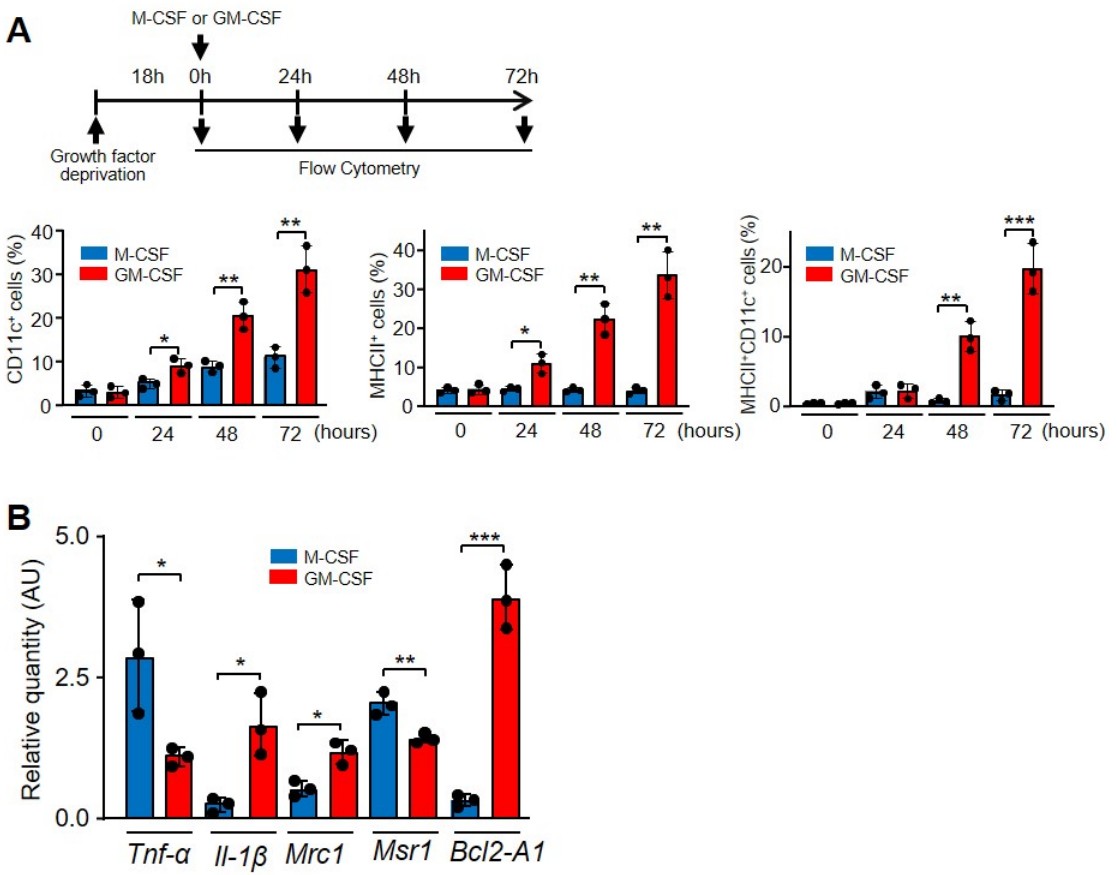
Figure 6. GM-CSF induced a different phenotype of macrophages in relation to M-CSF. ( A ) Characterization of CD11c and MHC II expression. The experimental design is shown at the top. After growth factor deprivation, macrophages were cultivated in the presence of the indicated growth factors for the indicated times and the surface expression was determined by FACS analysis and the corresponding antibodies. The graphics show the cells expressing single (CD11c or MHC II) or double markers ( n = 3). ( B ) Macrophages were cultured in the presence of M-CSF or GM-CSF for 24 h and the indicated gene expression was analyzed by real-time PCR ( n = 3). Each experiment was performed in triplicate, and the results are shown as the mean ± SD. * p < 0.05, ** p < 0.01 and *** p < 0.001 in relation to the corresponding treatments with M-CSF or GM-CSF, when all the independent experiments had been compared. Data were analyzed using Student’s t -test.